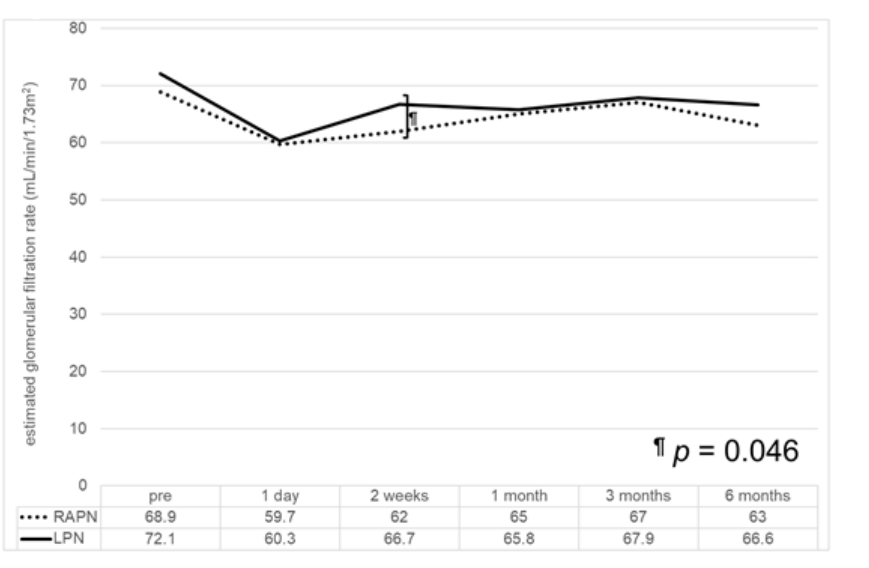
Figure 1. The chronological changes in the renal function after robot-assisted (RAPN) and laparo- scopic partial nephrectomy (LPN). At two weeks after surgery, the estimated glomerular filtration rate in the LPN group was significantly better than that in the RAPN group. However, there were no statistically significant differences in both groups at one day, and one, three, and six months after